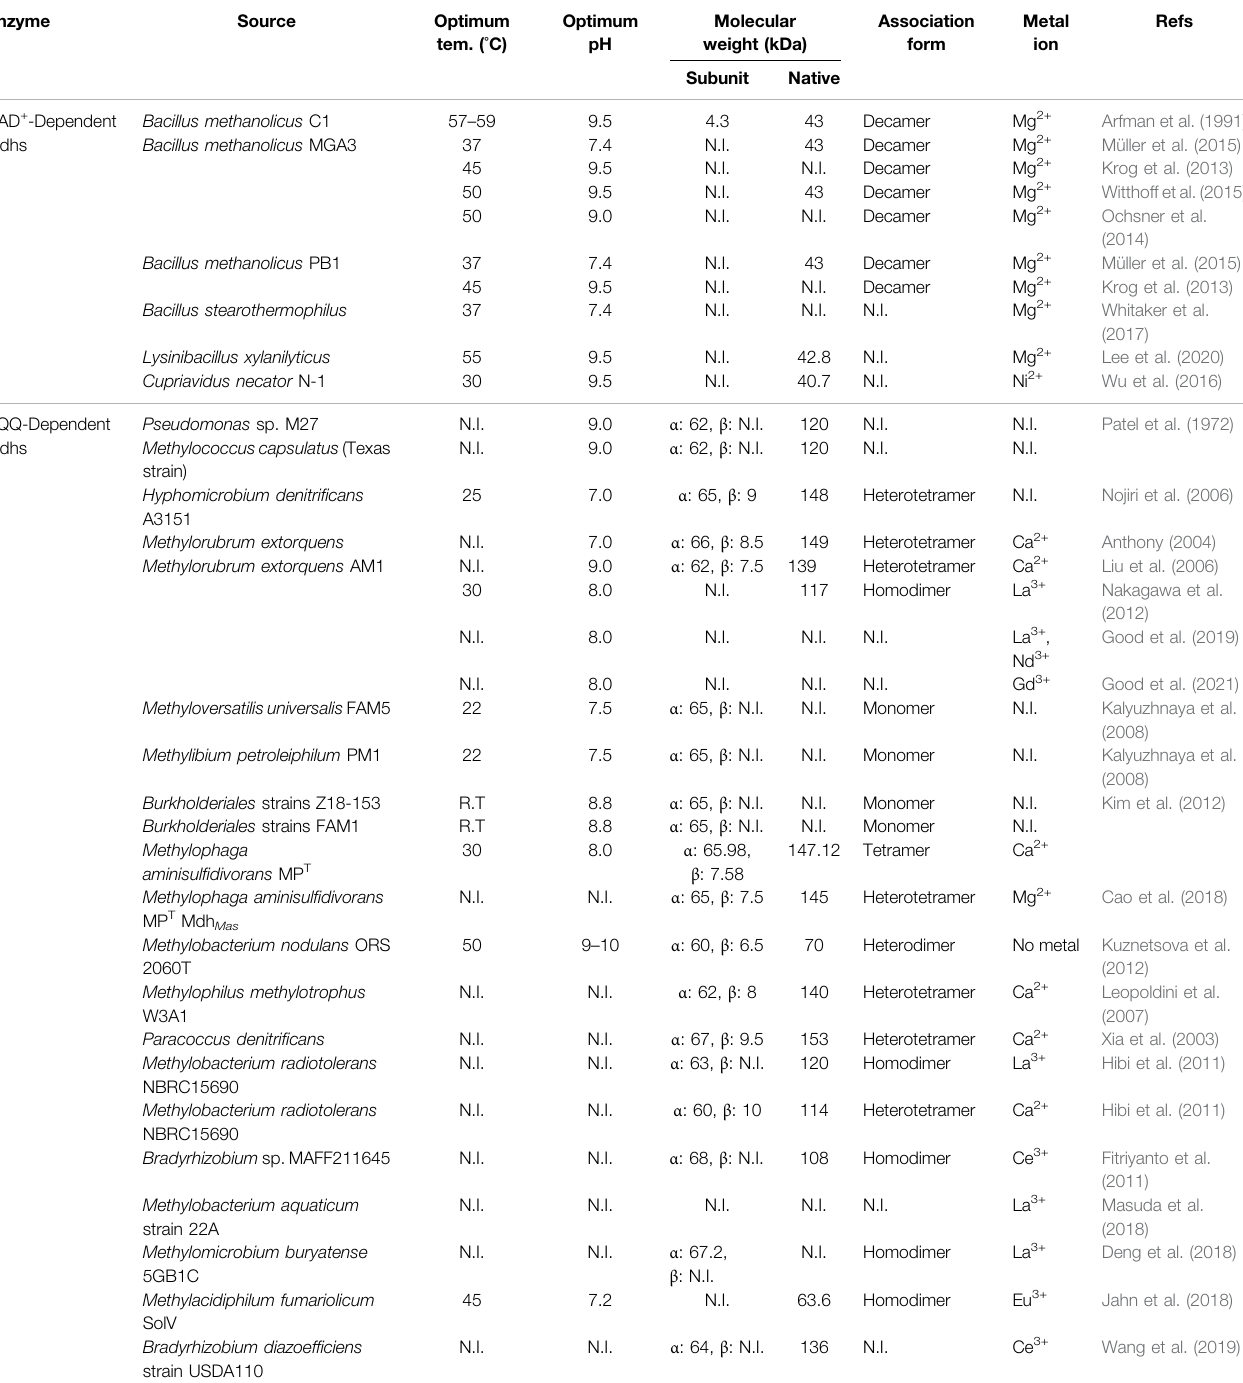
TABLE 1 | Enzyme properties of NAD + -Dependent Mdhs (EC number: 1.1.1.244) and PQQ-Dependent Mdhs (EC number: 1.1.2.7). Enzyme